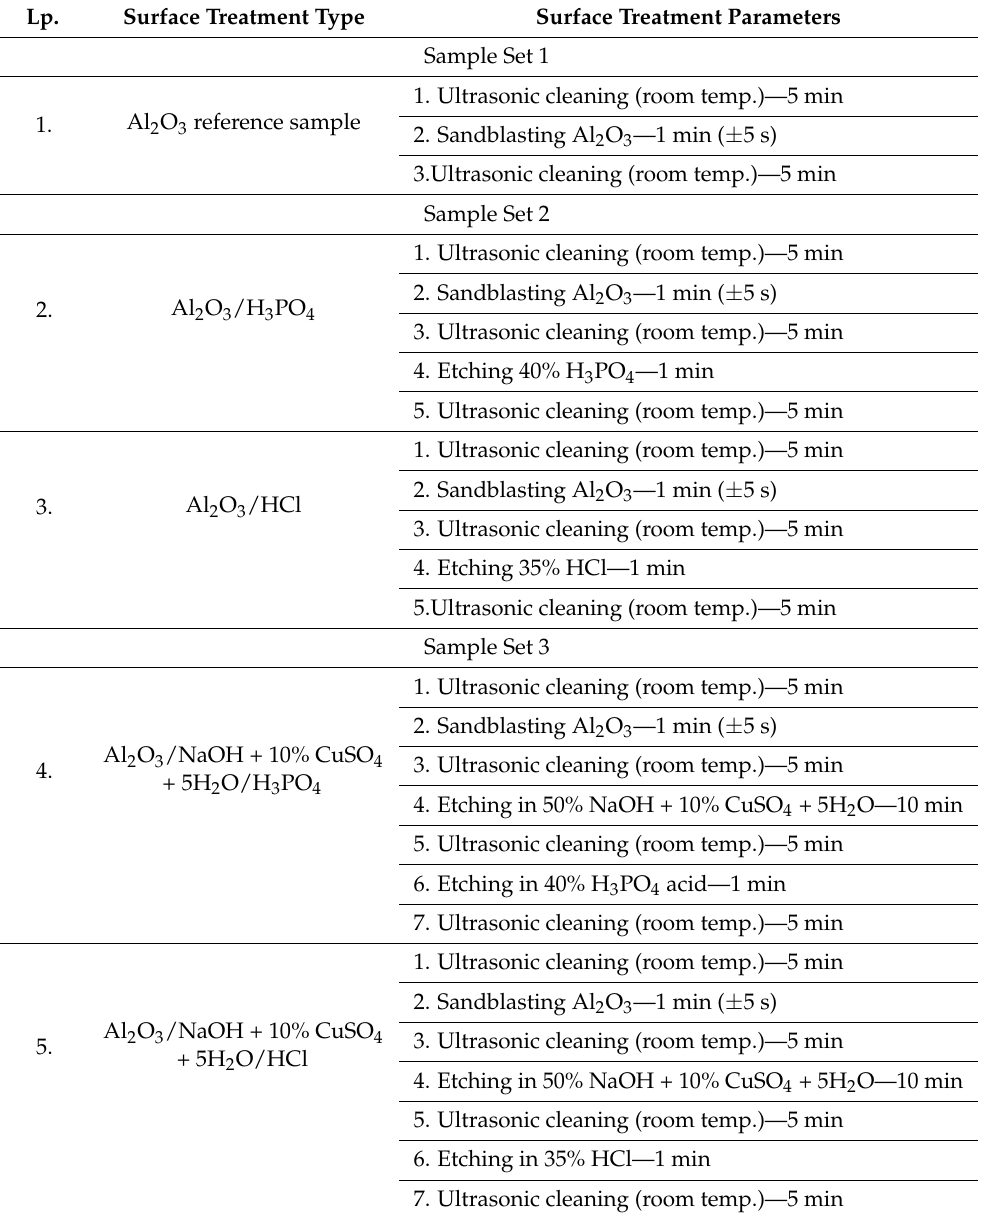
Table 2. Variants of mechanical and chemical surface treatment of titanium 99.2 substrates.